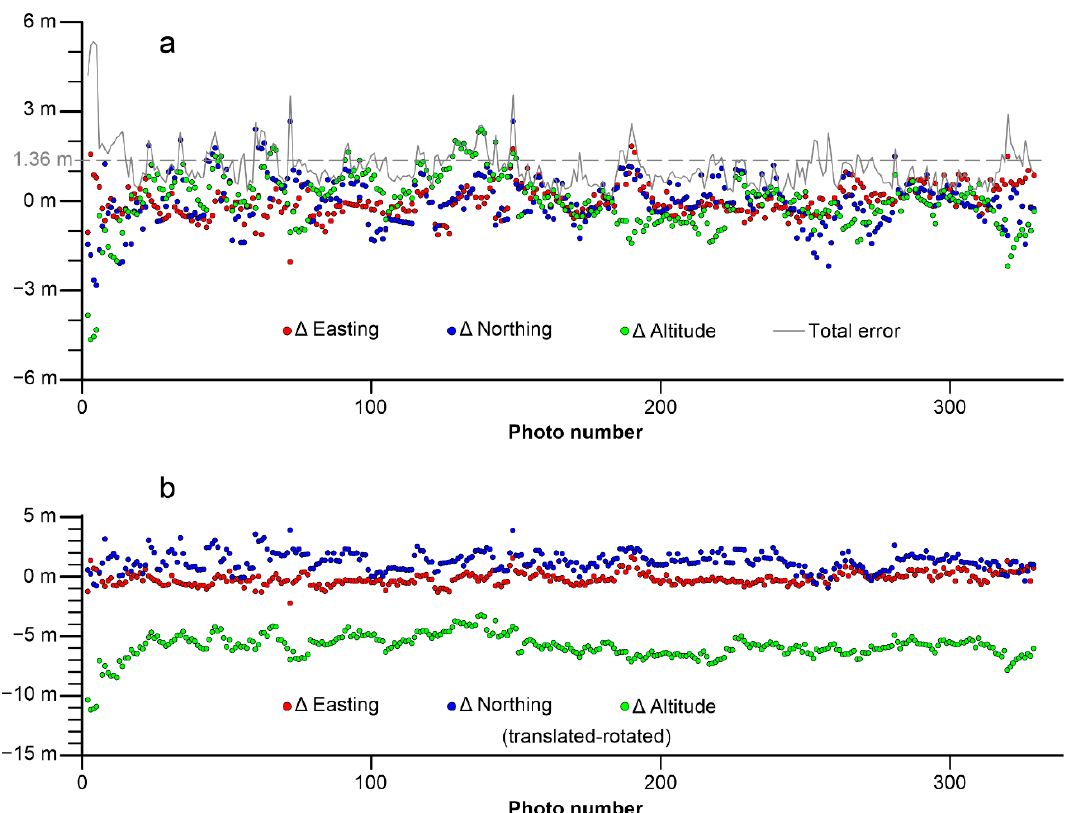
Figure 6. ( a ) iPhone 13 Pro geotag precision estimated via the difference between the iPhone 13 Pro’s geotags, as indicated in the EXIF metadata and their estimated values in Metashape. ( b ) iPhone geotag accuracy error estimated after aligning the iPhone model to the Air 2S model (benchmark). Note that the benchmark model has a − 8 m vertical translation from the real altitude ASL of the site.